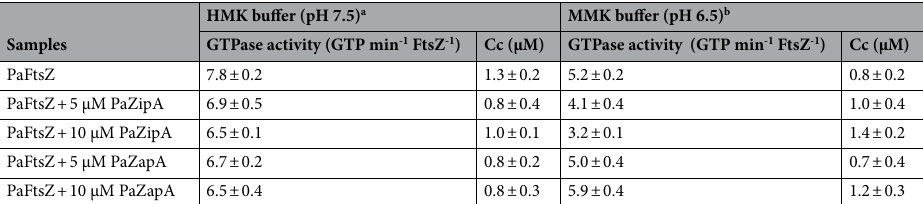
Table 1. GTPase activity of PaFtsZ in the absence of or in the presence of ZipA or ZapA in MMK and HMK buffer. Cc critical concentration. a HMK buffer: 50 mM HEPES, 100 mM KAc, 5 mM MgAc, pH 7.5. b MMK buffer: 50 mM MES, 100 mM KAc, 5 mM MgAc, pH